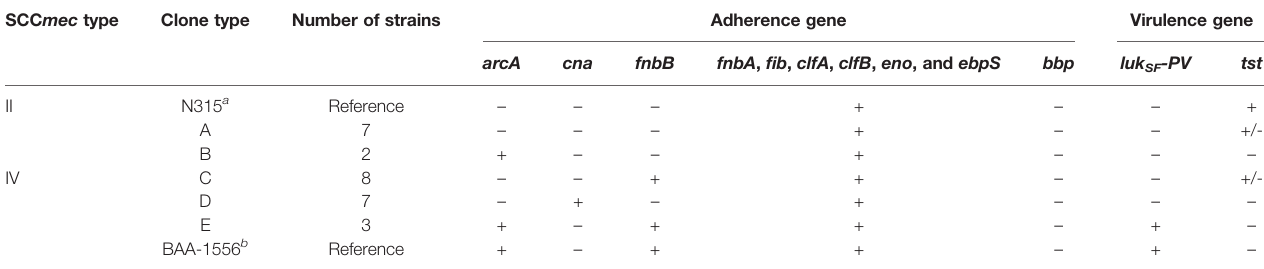
TABLE 1 | Molecular characteristics of methicillin-resistant Staphylococcus aureus (MRSA) strains used in this study (isolated in 2016).